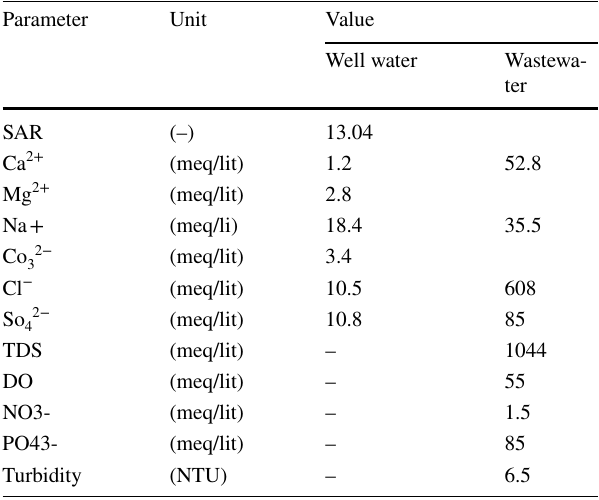
Table 1 Chemical analysis of well water and urban treated wastewa-